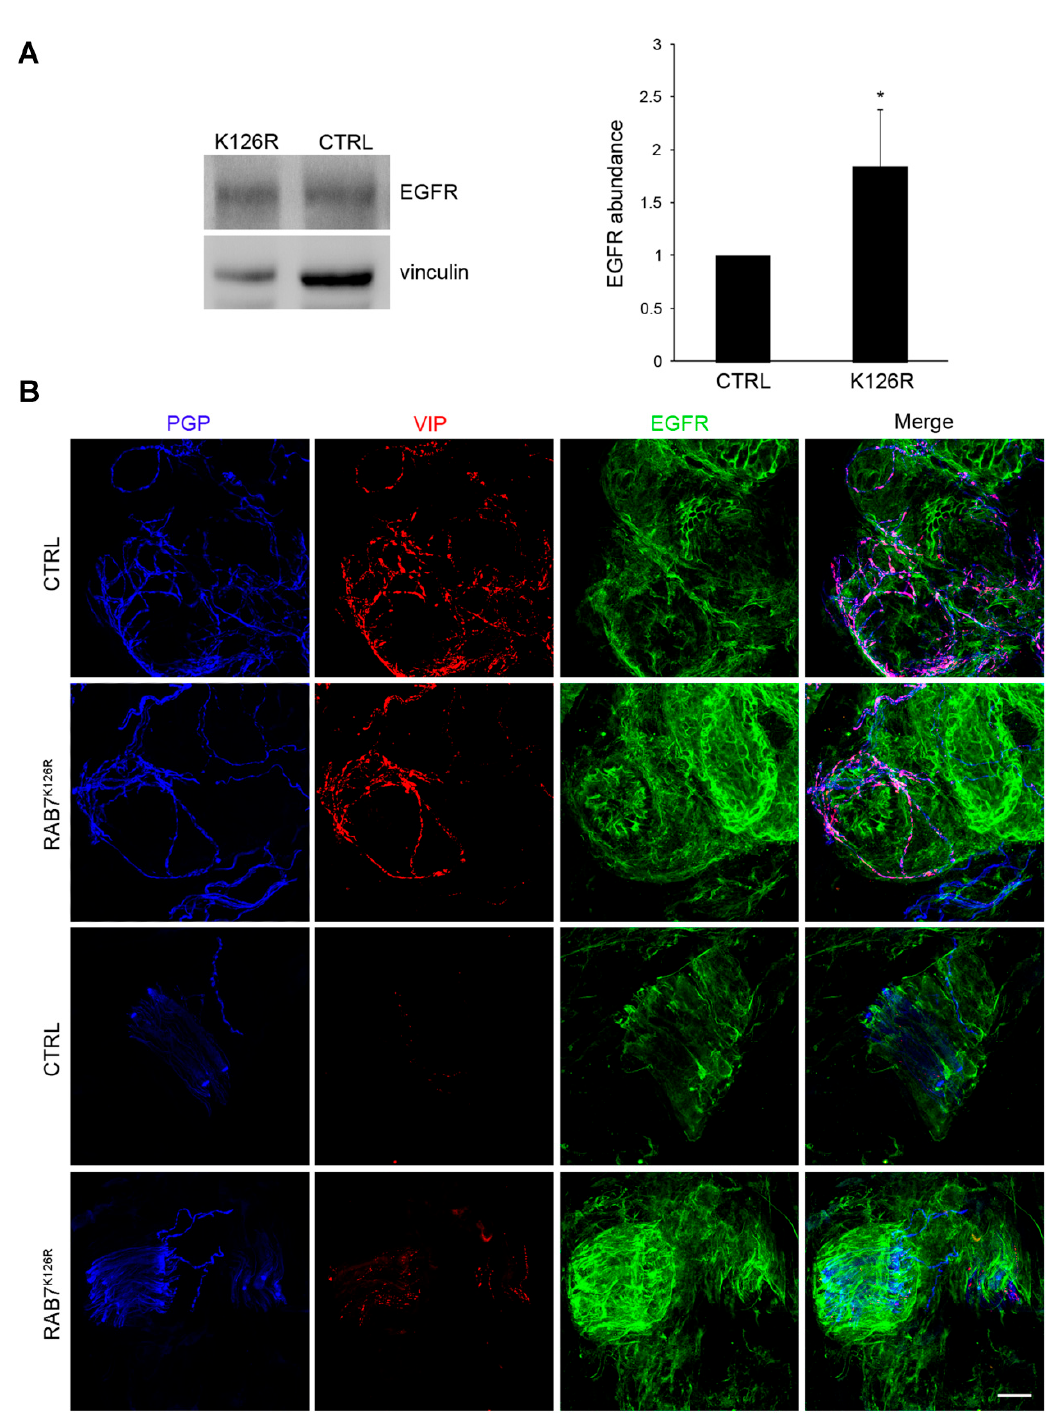
Figure 5. Expression of EGFR in proband sural nerve and skin biopsy sections. ( A ) Sural nerves from the proband and a gender-matched healthy control were lysed and EGFR protein expression was analyzed in both samples by WB using a specific anti-EGFR antibody. Antibody against vinculin was employed as a loading control. Densitometric analysis was performed with Gene Tools from Syngene. Data represent the mean ± s.e.m. of four experiments. The intensity of the EGFR band in CTRL cells has been set to 1. Statistical analysis was performed using Student’s t-test.* p < 0.05. ( B ) Confocal microscopy study of a skin biopsy from the proband and a healthy control using a specific anti-EGFR antibody. Nervous fibers are labeled with PGP9.5 (pan-axonal marker) and VIP (sympathetic cholinergic fibers’ marker) antibodies. Scale bar = 20 μ m in all images.